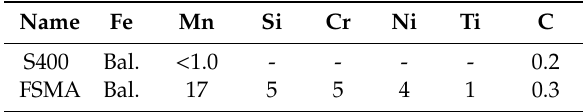
Table 1. Chemical composition (in wt.%) of S400 and FSMA 1